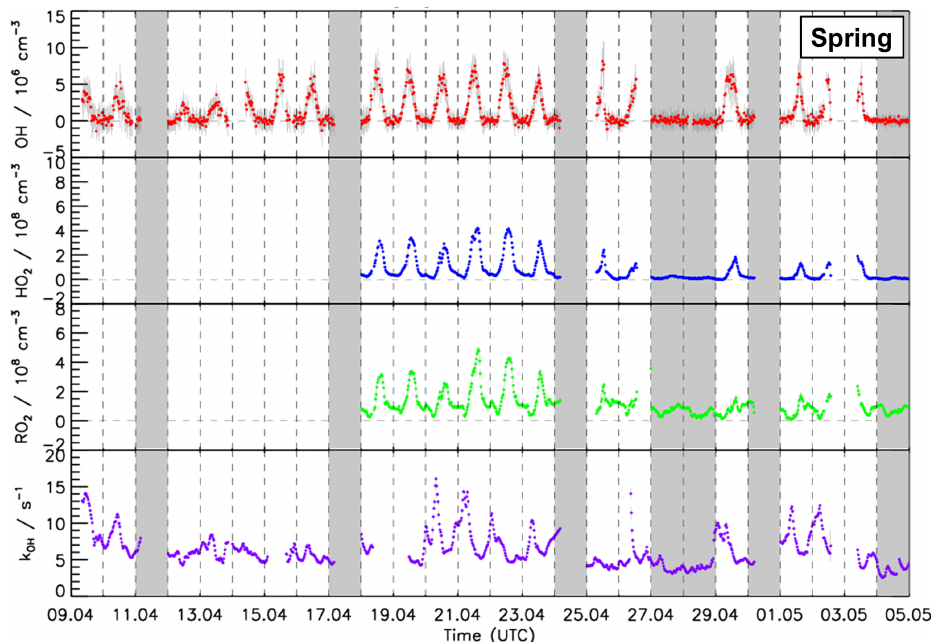
Figure 3. Time series of OH, HO 2 , and RO 2 radical concentration measured by the FZJ LIF–CMR instrument and measurements of the OH reactivity ( k OH ) measured in the spring period of the JULIAC campaign (Cho et al., 2022). Vertical bars represent 1 σ statistical errors. Vertical dashed lines denote midnight. Grey shaded areas indicate calibration days when no measurements were done and days when the chamber roof was closed due to bad weather conditions.